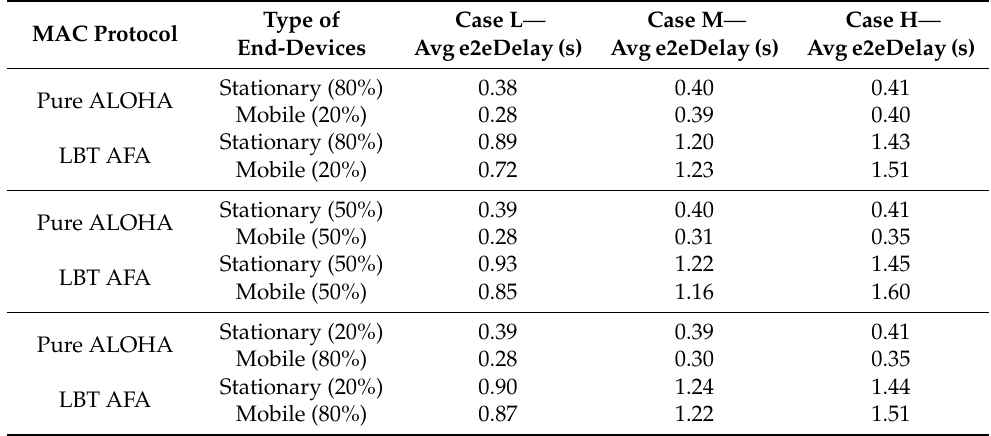
Table 13. Average e2eDelay with varying percentages of stationary and mobile end-devices. MAC